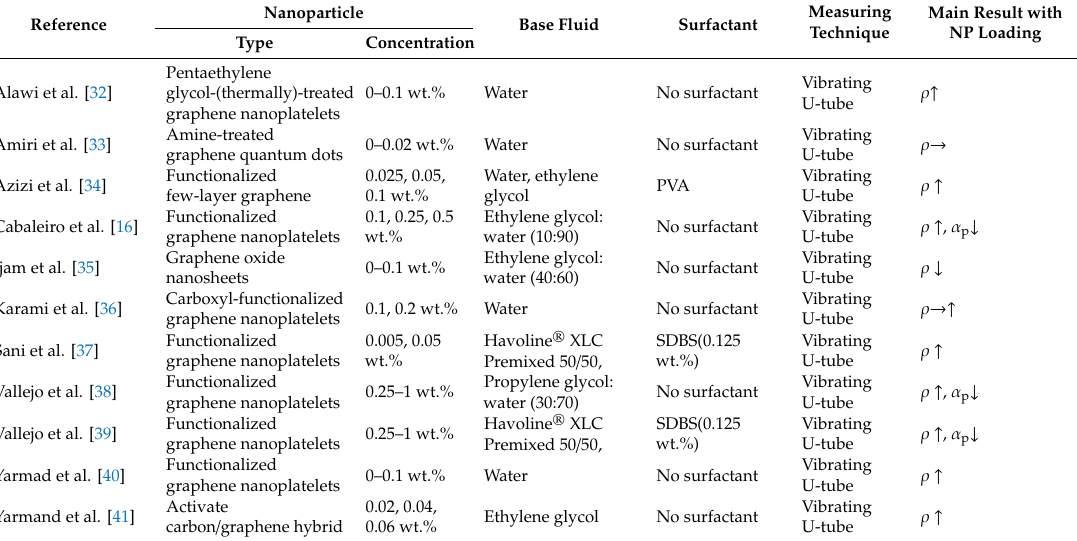
Table 2. Some volumetric behavior / density studies on graphene